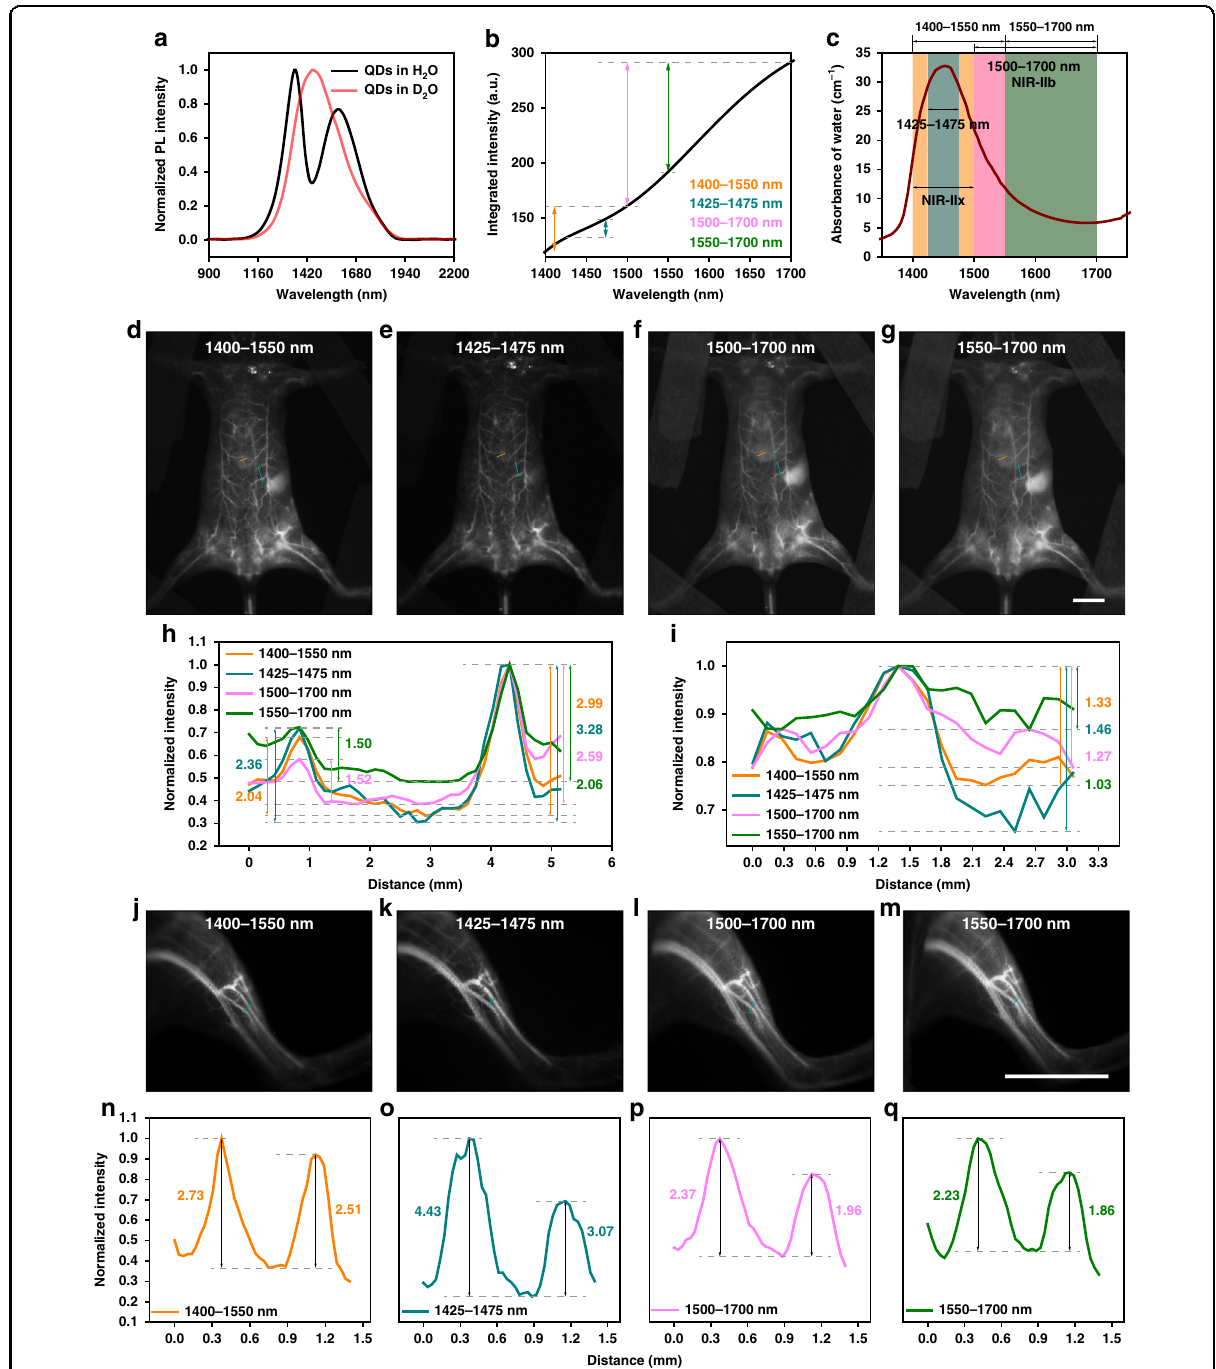
Fig. 5 Comparison of in vivo fl uorescence imaging of mice in 1400 – 1550, 1425 – 1475, 1500 – 1700, and 1550 – 1700 nm. a The emission spectra of PEGylated 1450-PbS/CdS QDs in water and heavy water. b The integrated emission intensity of PEGylated 1450-PbS/CdS QDs in water. The value difference on the ordinate represents the total emission intensity in the corresponding spectral (abscissa) range. c The absorbance of water within 1300 – 1800 nm 38 . The whole-body imaging of the same mouse in ( d ) 1400 – 1550 nm, ( e ) 1425 – 1475 nm, ( f ) 1500 – 1700 nm, and ( g ) 1550 – 1700 nm. Cross-sectional fl uorescence intensity pro fi les along ( h ) the indigo lines and ( i ) brown lines of the blood vessel in ( d – g ). The numbers show the SBRs. The hind limb imaging of the same mouse in ( j ) 1400 – 1550 nm, ( k ) 1425 – 1475 nm, ( l ) 1500 – 1700 nm, and ( m ) 1550 – 1700 nm. n – q Cross-sectional fl uorescence intensity pro fi les along the indigo lines of the blood vessel in ( j – m ). The numbers show the SBRs. Scale bars: 10